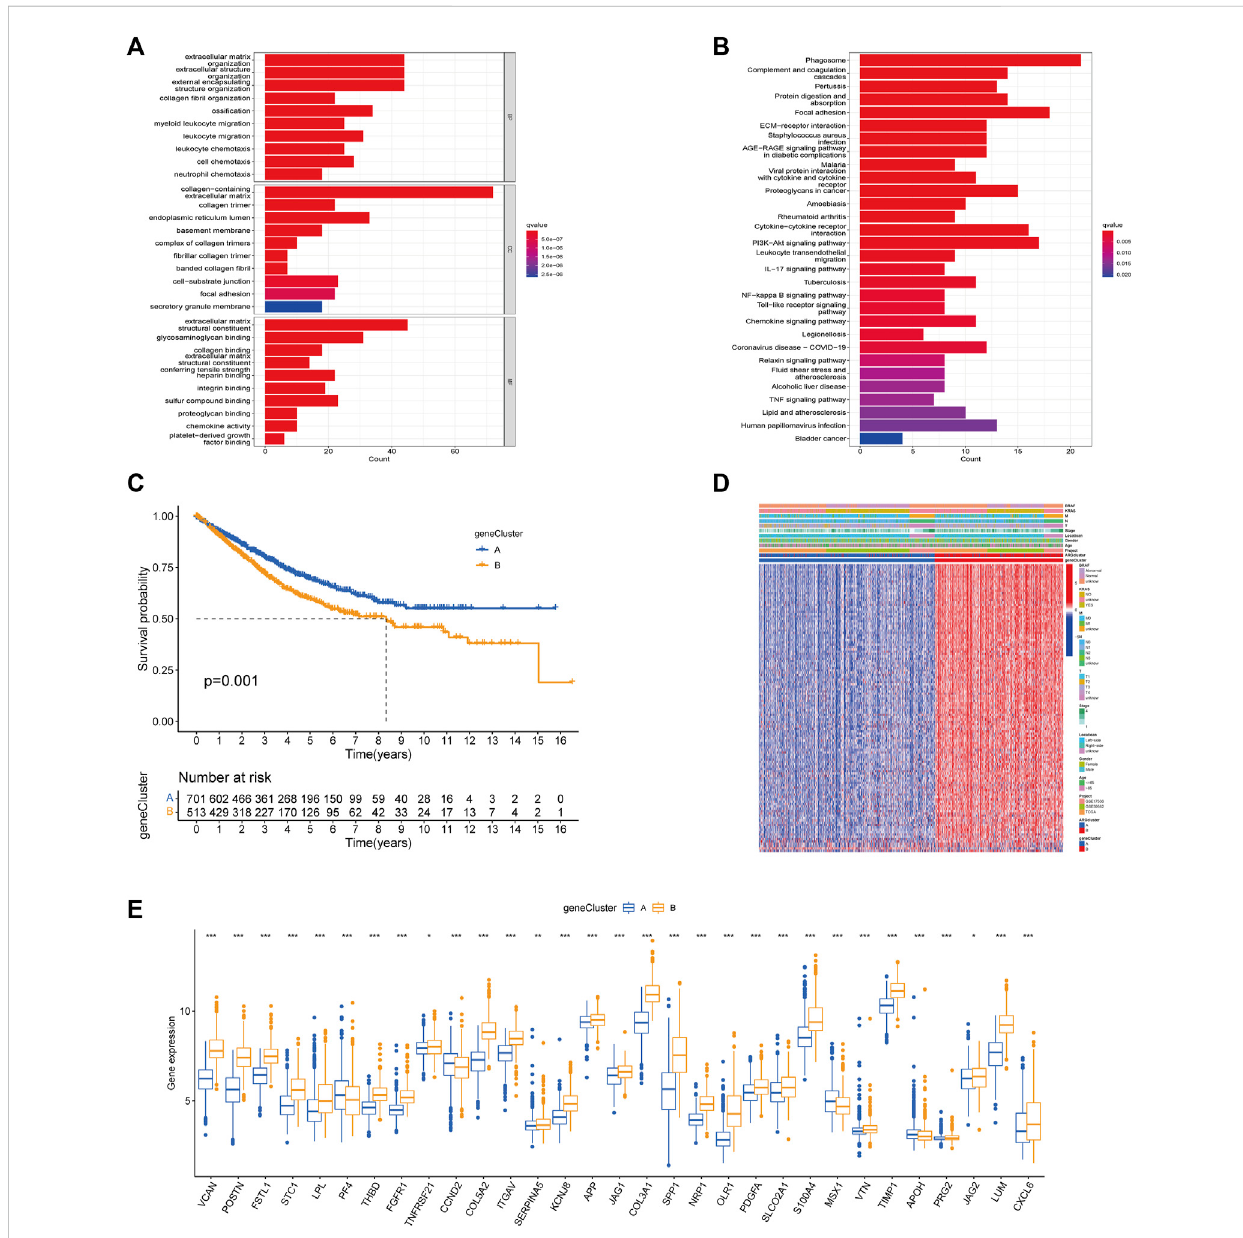
FIGURE 4 Based on DEGs to identify gene subtypes. (A, B) Enrichment analysis of DEGs between two subtypes using GO and KEGG. The color depth of the barplots representedthenumberofgenesenriched. (C) K-Mcurvesfor OSofthetwogenesubtypes (Log-ranktest, p =0.001). (D) Relationshipbetween thetwogenesubtypesandclinicopathologicalfeatures. (E) Expressiondifferencesof36ARGsbetweenthetwogenesubtypes.Theasterisksrepresented the statistical p -value (* p < 0.05; ** p < 0.01; *** p <